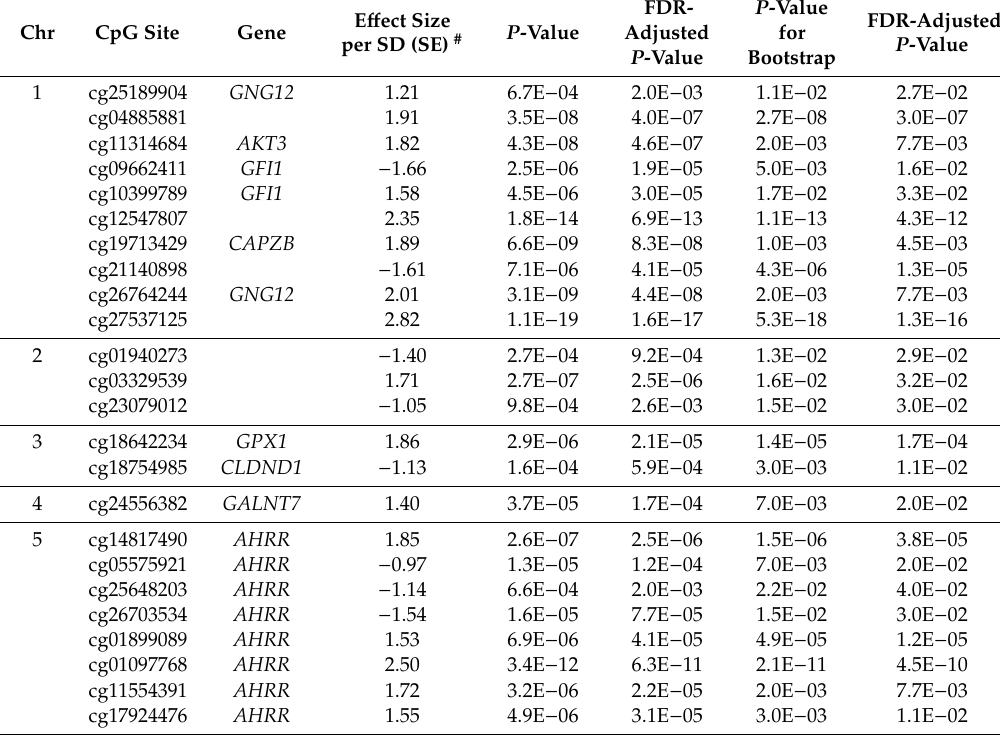
Table 3. CpG Sites ( P < 0.05) associated with DNA methylation phenotypic age (DNAmPhenoAge)